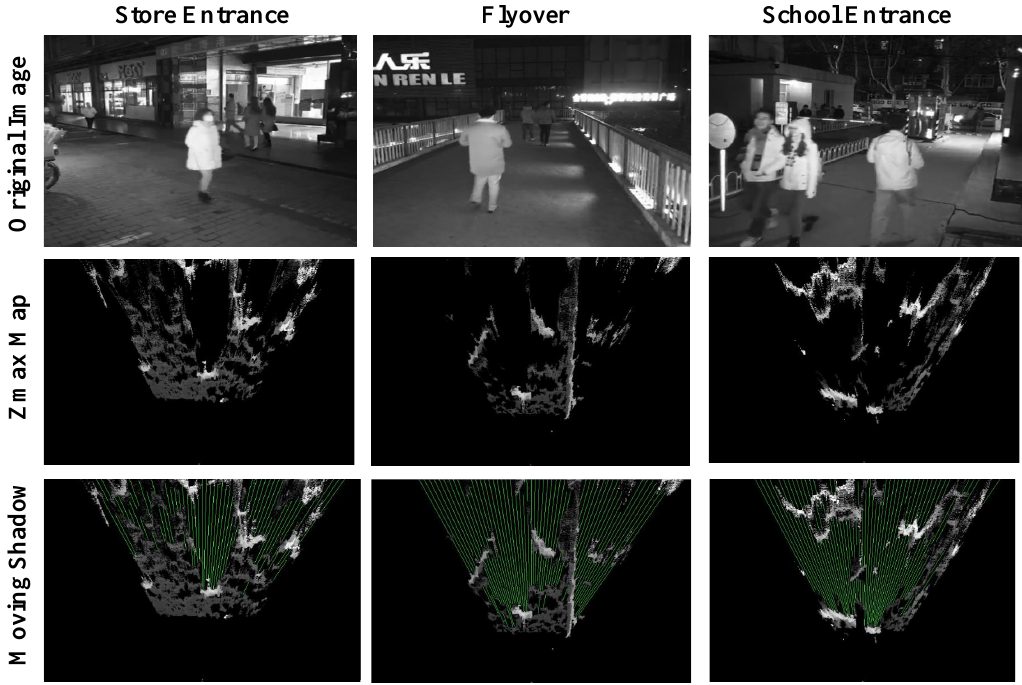
Figure 4. Examples of moving shadow segmentation under various outdoor scenes at night. Please note that by detecting motion shadows, our system can use the shadows to remove some false targets by judging whether there is any shadow behind the detected foreground pedestrian and more accurately detect targets in dim lighting of various occlusion